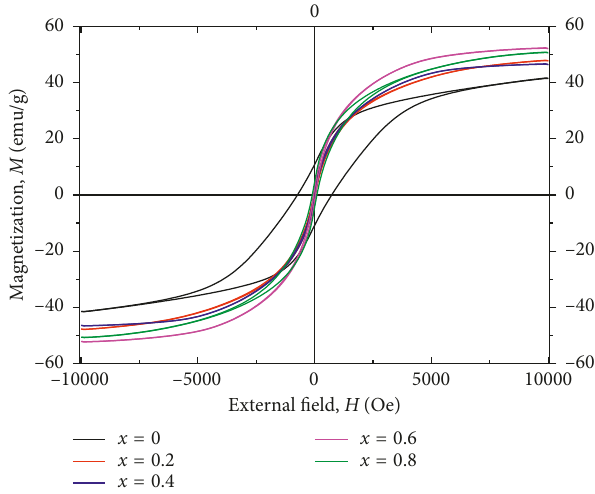
3 [Cu 0.8 − x Zn x Mn 0.2 ] 2 Fe 24 O 41